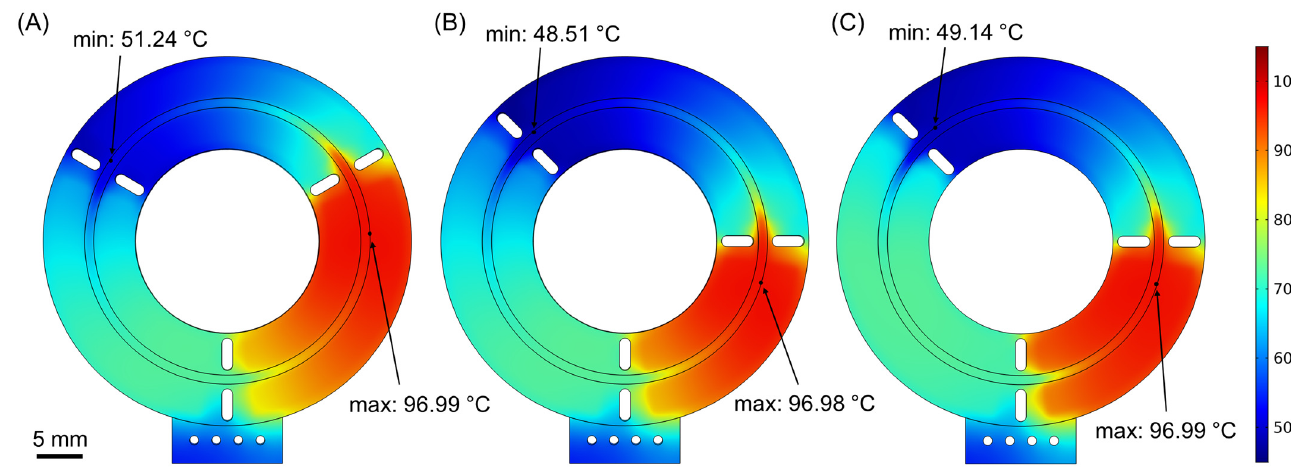
Figure 5. ( A – C ) Temperature distributions (at the middle height of the microchannel) for the three microreactor geometries that are shown in Figure 3, as calculated in the computational study. Each microreactor geometry operates at the fastest possible flow rate ( 𝑉(cid:4662) 1 = 1.26 μ L/s, 𝑉(cid:4662) 2 = 1.31 μ L/s, 𝑉(cid:4662) 3 = 1.65 µ L/s), with the cycle times being 7.5 s, 7.2 s, and 5.7 s, respectively. Maximum and minimum values refer to the temperatures of the sample inside the microchannel.